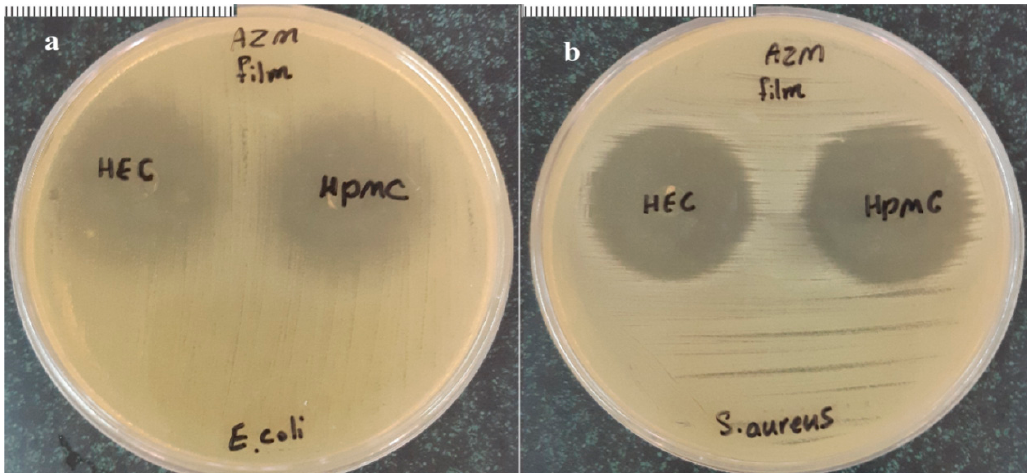
Figure 8. The areas of inhibited growth of ( a ) Escherichia coli and ( b ) Staphylococcus aureus around AZM film-HPMC and AZM film-HEC. Note: Scale: 1 mm.